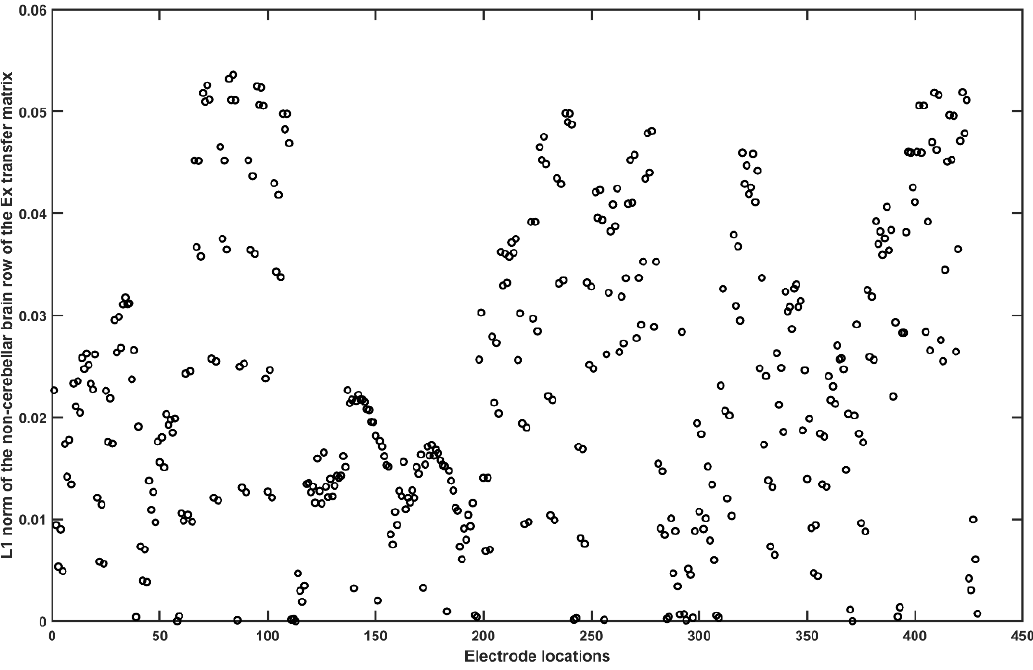
Figure A4 . L1 norm of the non − cerebellar brain row (= 35) of the Ex transfer matrix.